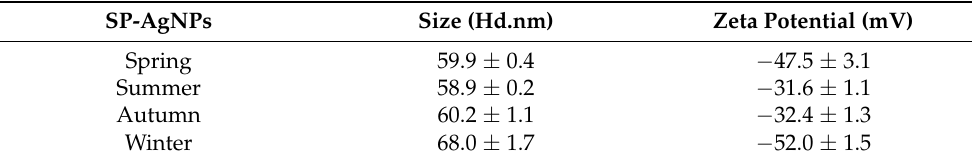
Table 1. Size and zeta potential of seasonal samples of